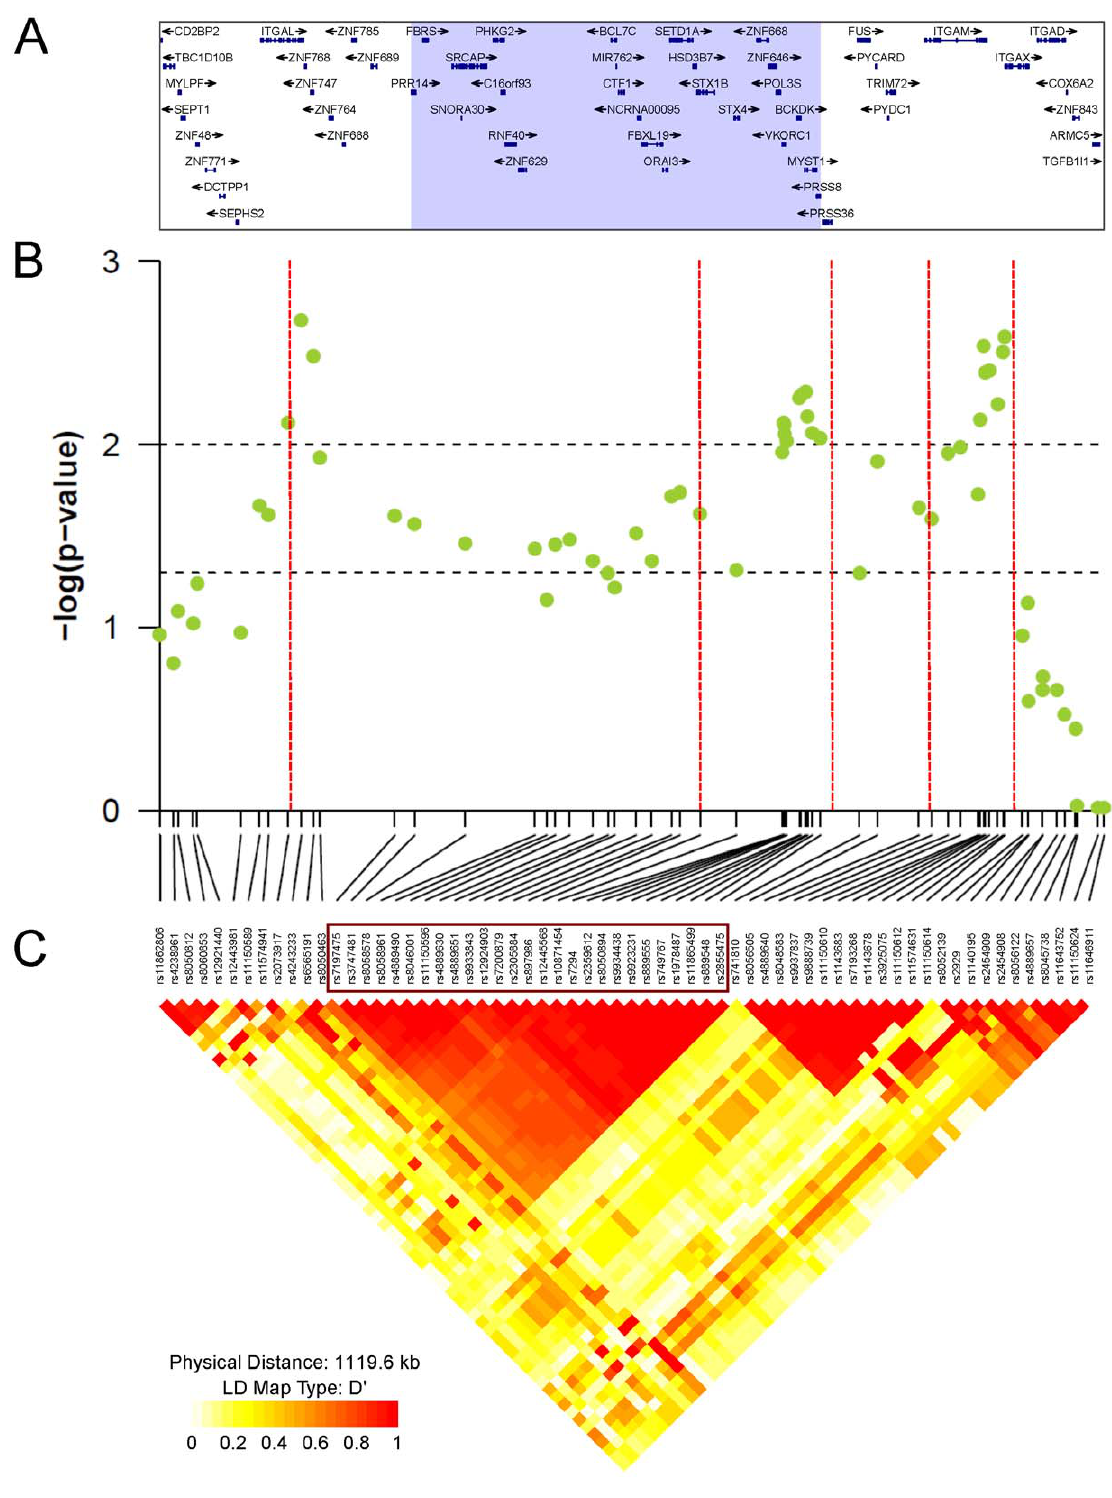
Figure 4. Detailed analysis of a 1.1 Mb genomic region surrounding the VKORC1 gene locus in East Asia. The boundaries of the region displayed (chr16:30,271,572-31,391,123; UCSC human genome build hg18) were chosen so as to include the three clusters of significant scores detected in East Asia by the selection tests in the 2 Mb region centered on VKORC1 (Figure 3). ( A ) Name and location of genes. Exons are displayed as blue boxes and the transcribed strand is indicated with an arrow. Genes located in the block of strong LD encompassing VKORC1 and including the SNPs in the red box shown in Figure 4C, are highlighted in the grey area. ( B ) XP-EHH results in East Asia. The significance of the XP- EHH scores ( 2 log 10 empirical p -value) are shown for individual SNPs with a MAF $ 0.01 in East Asia. Horizontal dashed lines indicate 0.05 and 0.01 chromosome-wide significance levels. Recombination hotspots detected in HapMap Phase II data are indicated by red vertical dotted lines. The data